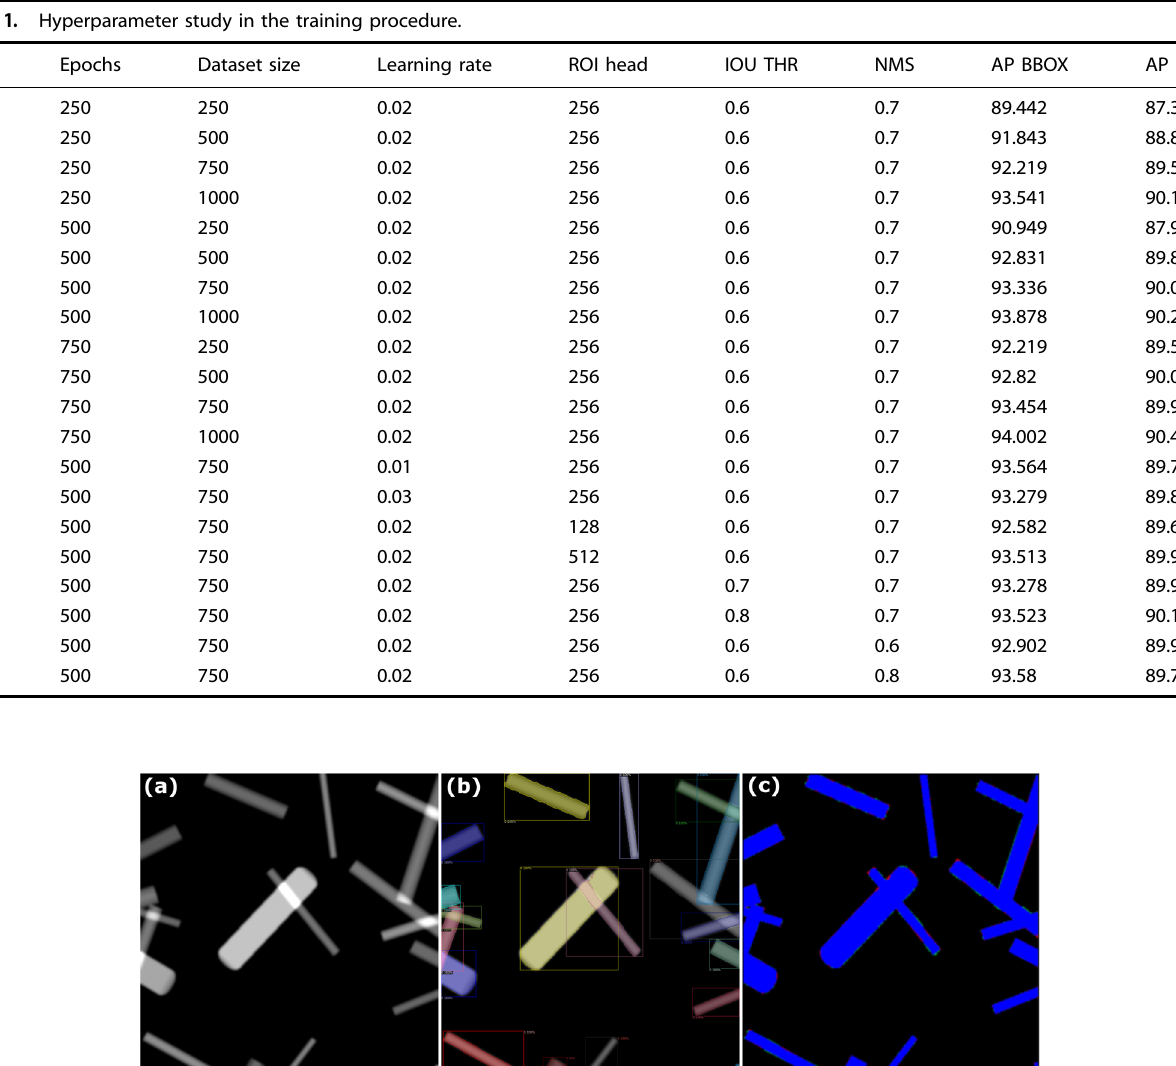
Fig. 3 Model prediction on V 2 O 5 nanowires within a synthetic image (512 × 512 pixels). a Test image. b Predicted instance masks with lower opacity plotted on the test image. c Semantic binary mask. Blue: TP, Red: FN, Green: FP; every nanowire instance in the present synthetic image has been successfully segmented with highest accuracy and negligible deviation in the overlapping regions and particle boundaries.